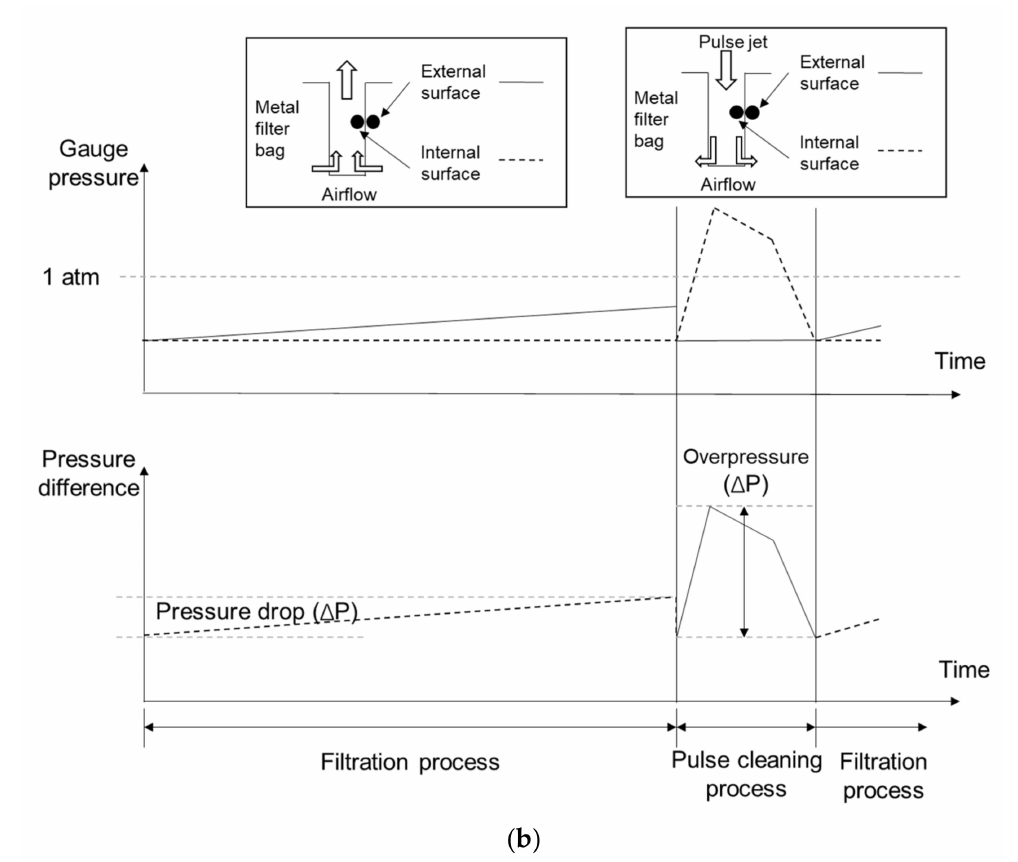
Figure 12. The pressure drop varies as the time during the filtration and cleaning process for purification the dust-laden airflow. ( a ) The filtration and cleaning process. ( b ) The pressure drop varies with time during the filtration and cleaning